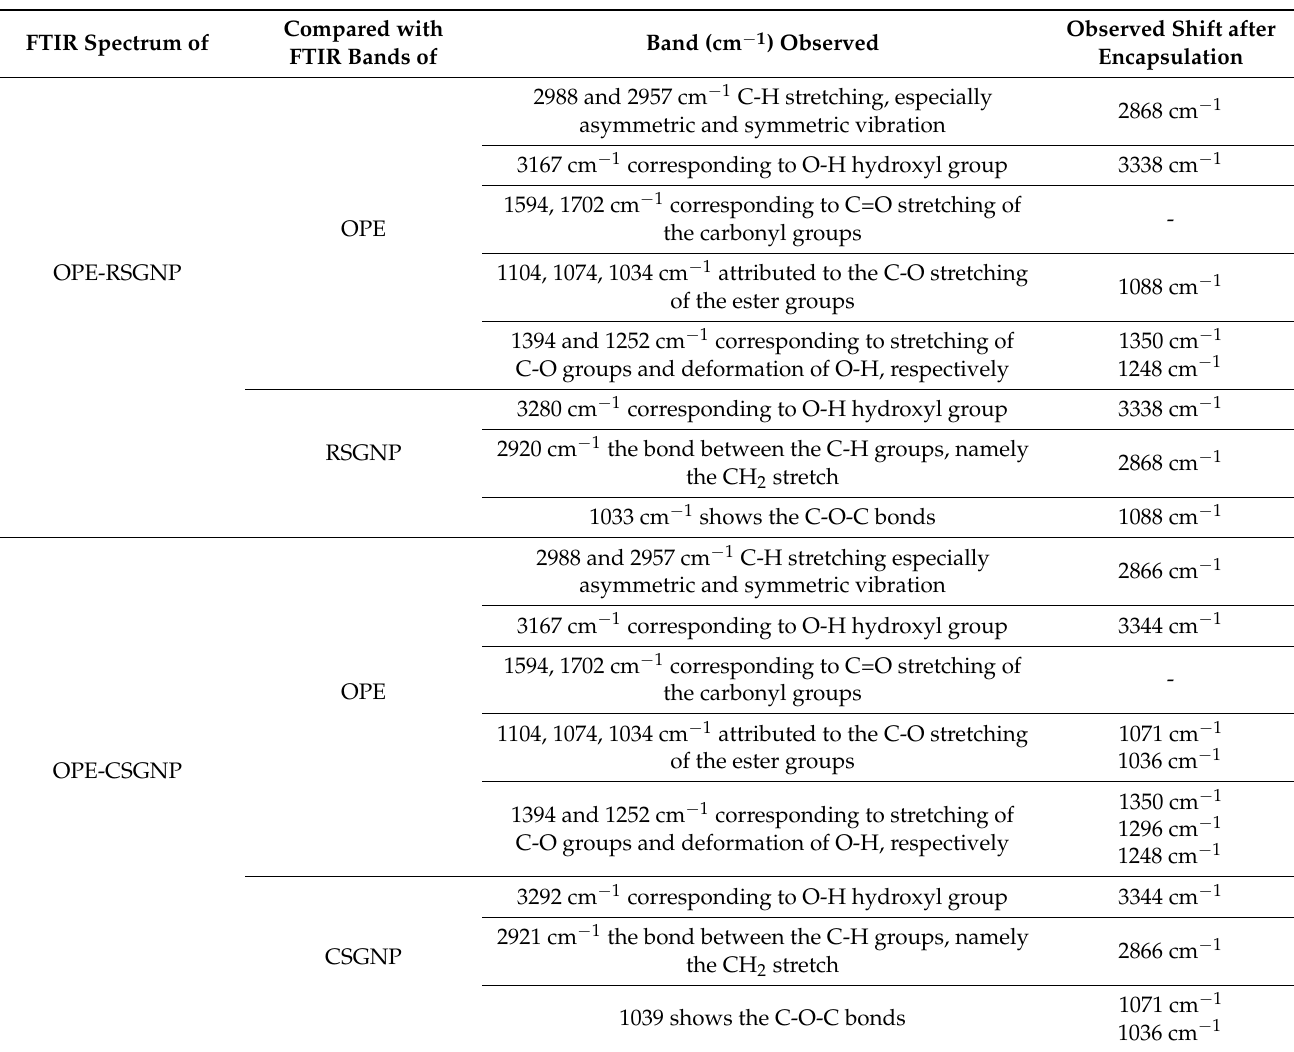
Table 4. FTIR spectrum bands of